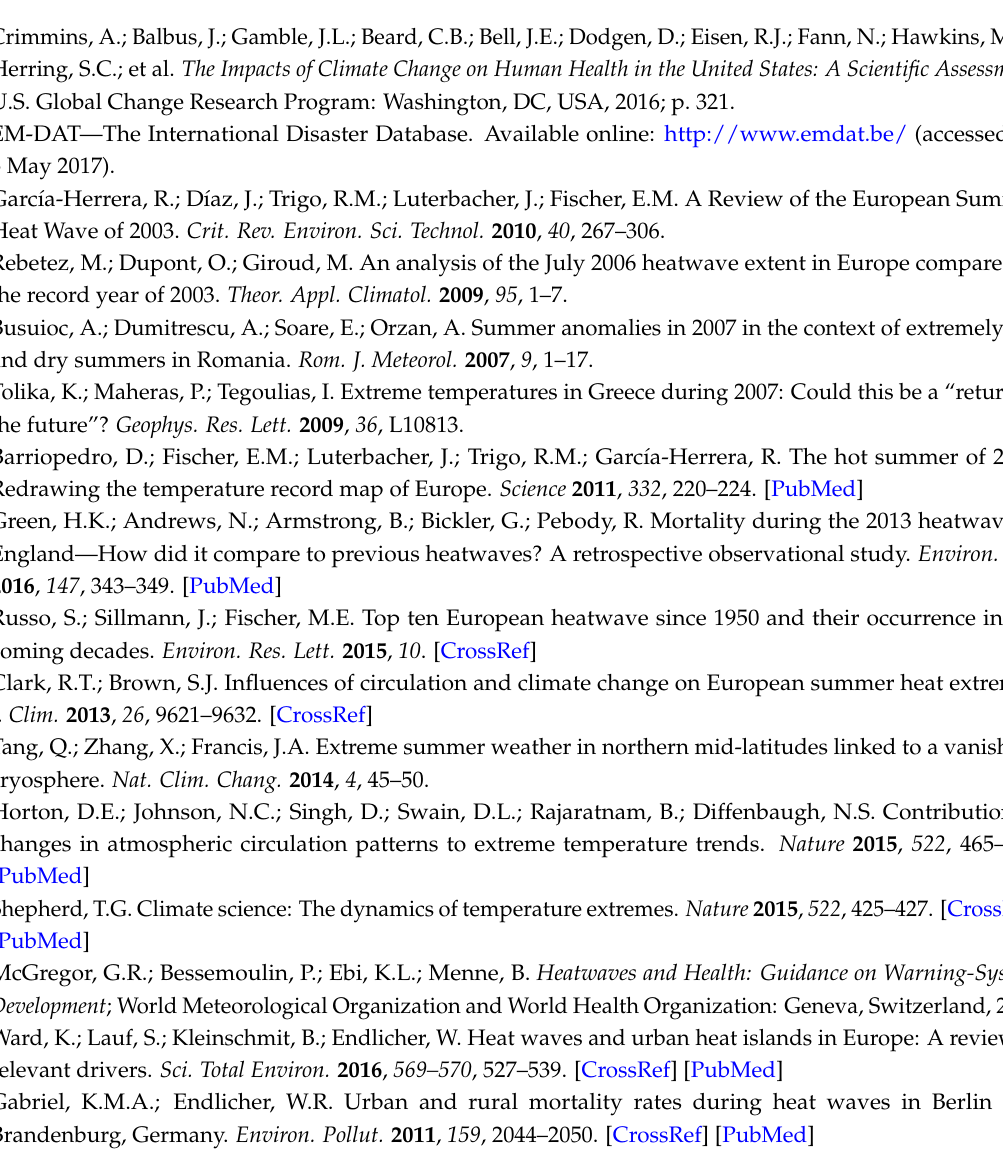
Table S1: Descriptive statistic of the heatwave (HW) characteristics during the 1980–2015 period in the 28 EU Member States capitals. HW D : number of HW days; HW L : long HWs; HW I : high-intensity HWs; HW T : timing of the first simultaneously long and high-intensity HW; ATmax and Tmin represent the average maximum apparent and minimum temperatures respectively during HW D ; 75th and 25th percentiles in square brackets; frequency of years with at least one simultaneously long and high-intensity HW in round